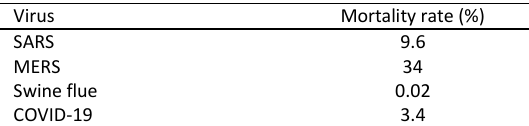
Table 3: Mortality rate of other diseases caused by viruses Virus